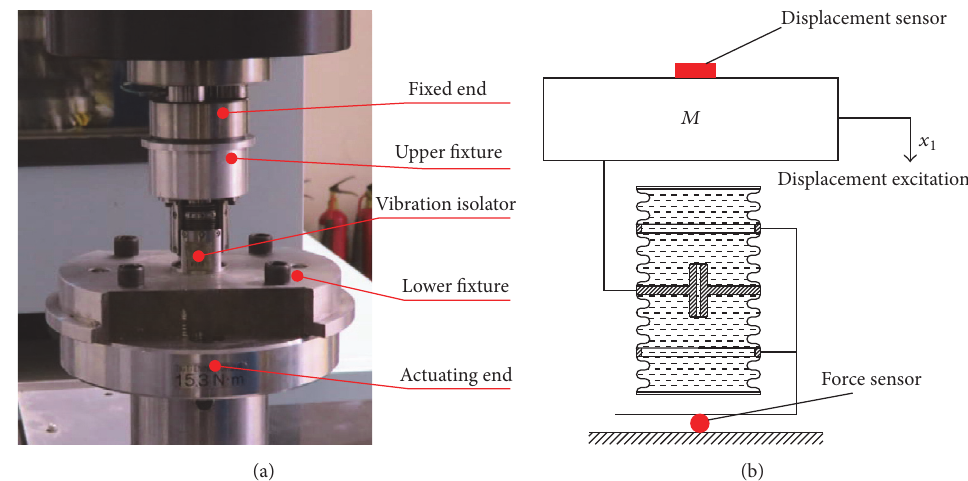
Figure 6: (a) Installation status of the isolator. (b) Schematic diagram of the